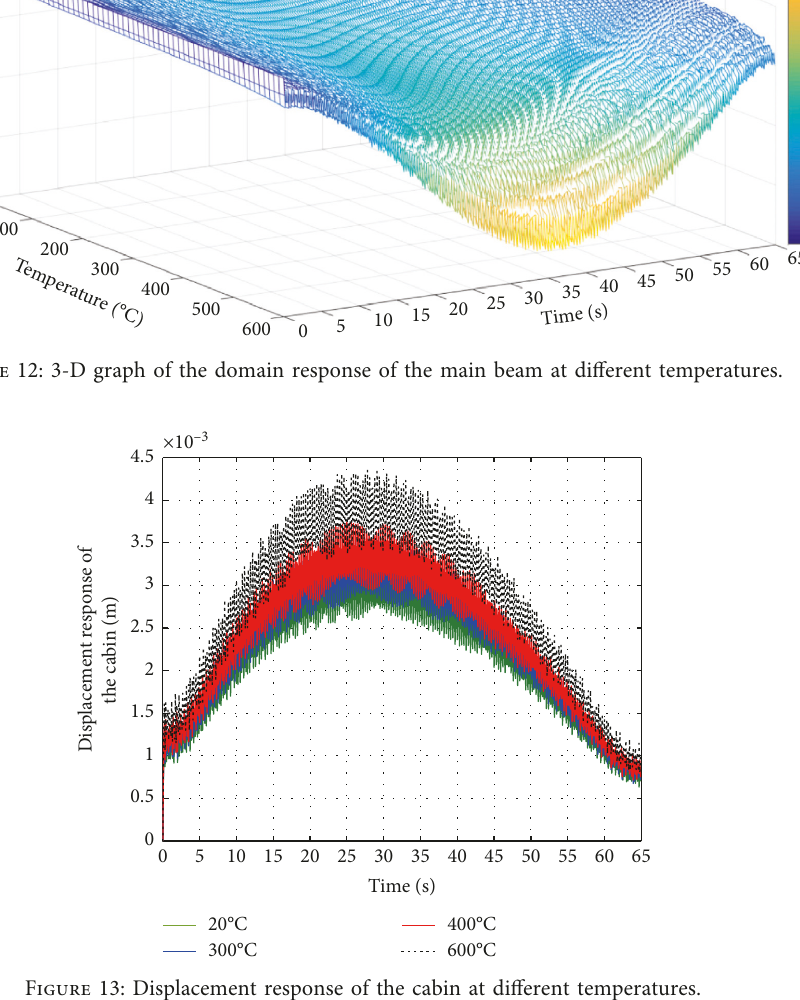
Figure 13: Displacement response of the cabin at different temperatures.